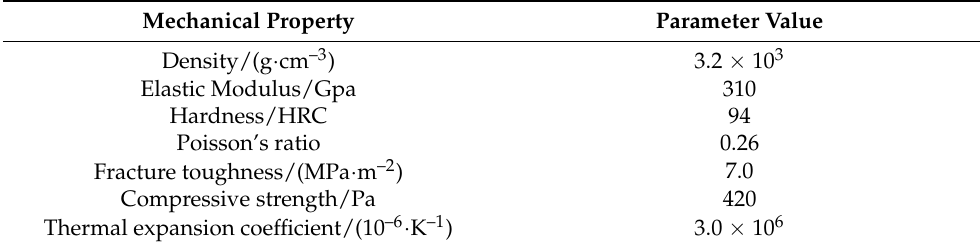
Table 1. Performance parameters of silicon nitride ceramic ball.